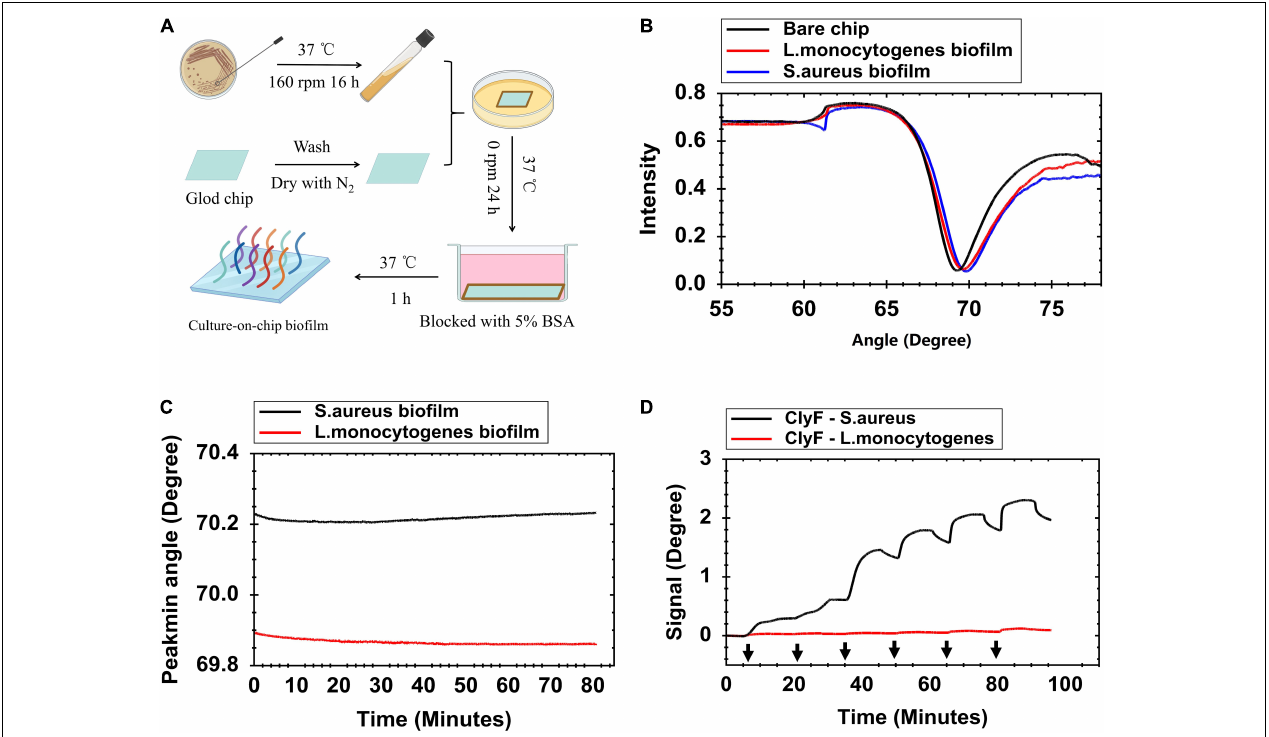
FIGURE 1 | Formation and characterization of S. aureus biofilm on the gold sensor chip. (A) Schematic presentation of the culture-on-chip biofilm formation process. (B) Full angular spectrum of a clean gold surface (black line), S. aureus biofilm (blue line), and L. monocytogenes biofilm (red line) modified gold surface chip. (C) Contact angle change measurements when flowing PBS over the modified chip at 30 µ l/min for 80 min to evaluate stability of biofilms. (D) SPR signal response for determining lysin adsorption on bacterial biofilm at increased concentrations of ClyF (black arrows from left to right mean 0.078, 0.156, 0.313, 0.625, 1.25, and 2.5 µ M, respectively). “Signal” means change in Peakmin